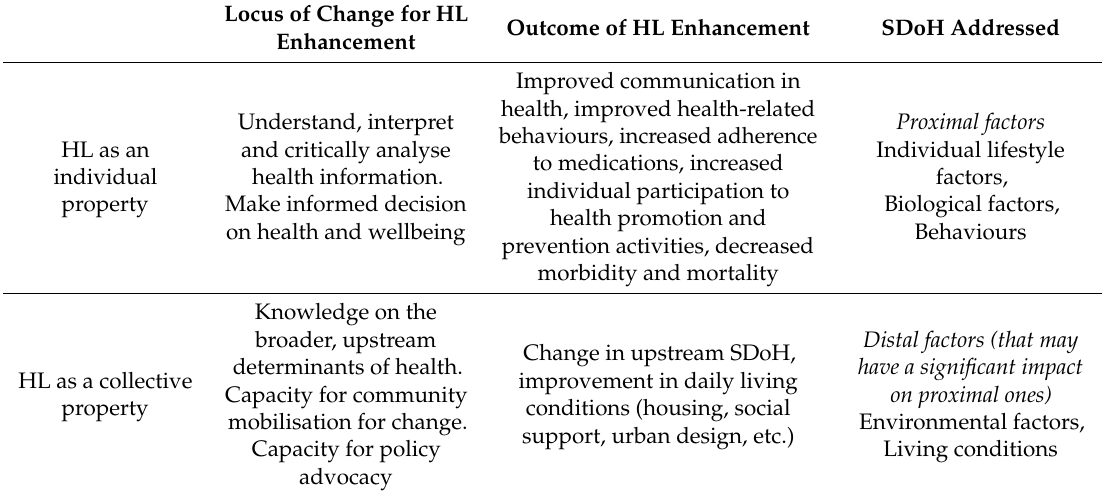
Table 2. Synthesis of two general perspectives of health